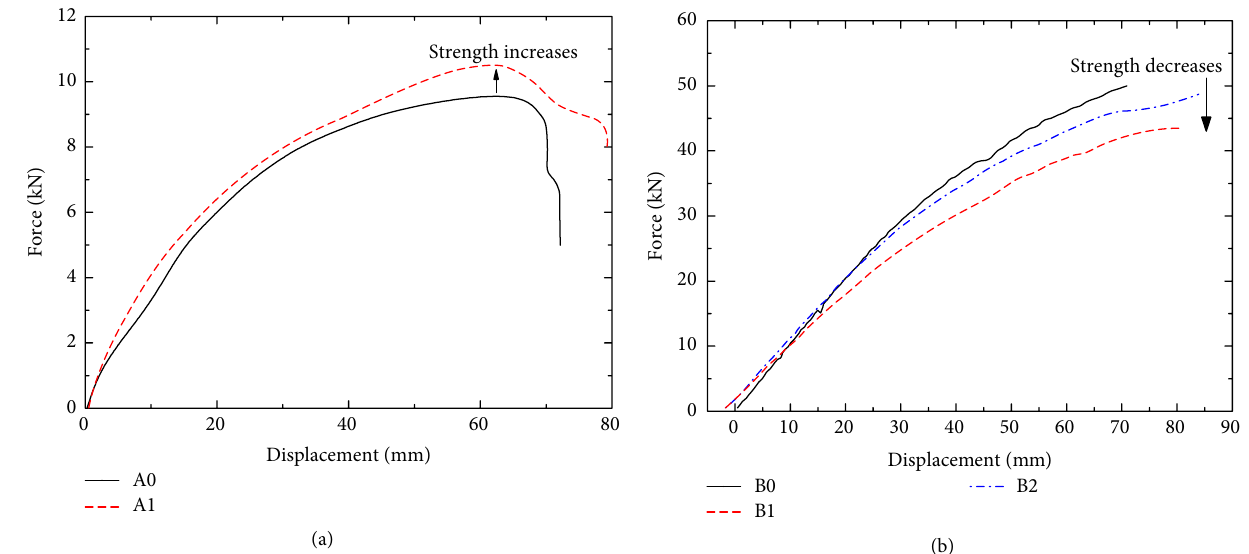
Figure 10: Load–deflection curves at the midspan: (a) first series, and (b) second series.